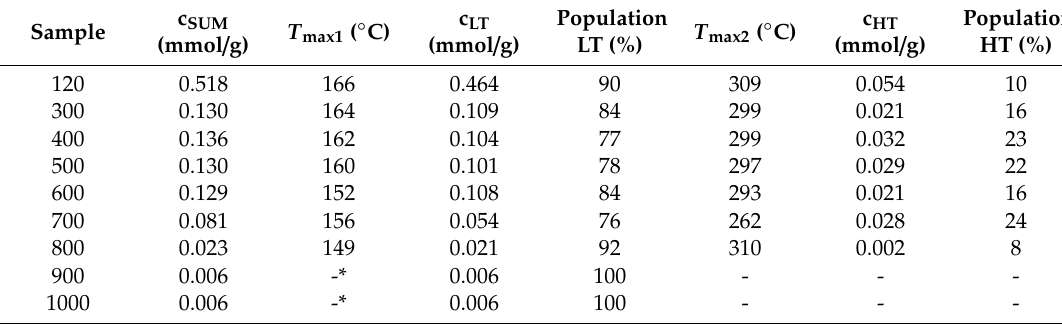
Table 7. Properties of acid sites determined by NH 3